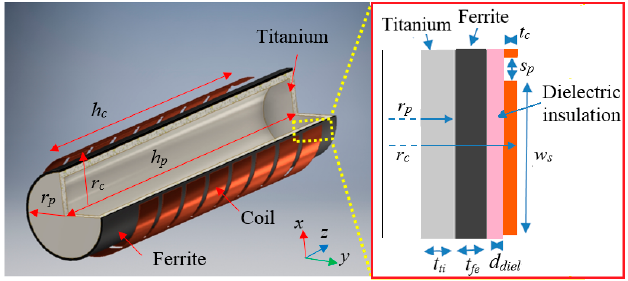
Figure 11. Secondary coil configuration.